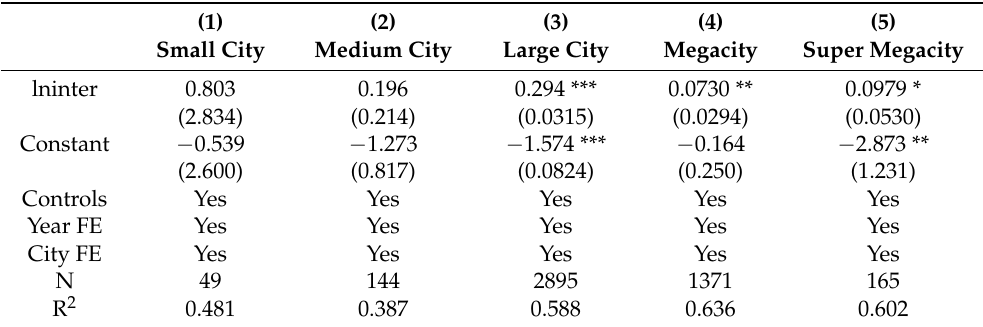
Table 9. The impact of population